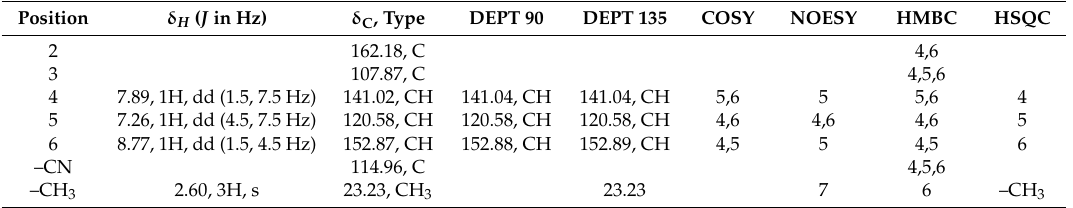
Table 4. One-dimensional (1D) and two-dimensional (2D) NMR spectral data of 2-(methyldithio)pyridine- 3-carbonitrile (2-Medpy-3-CN).